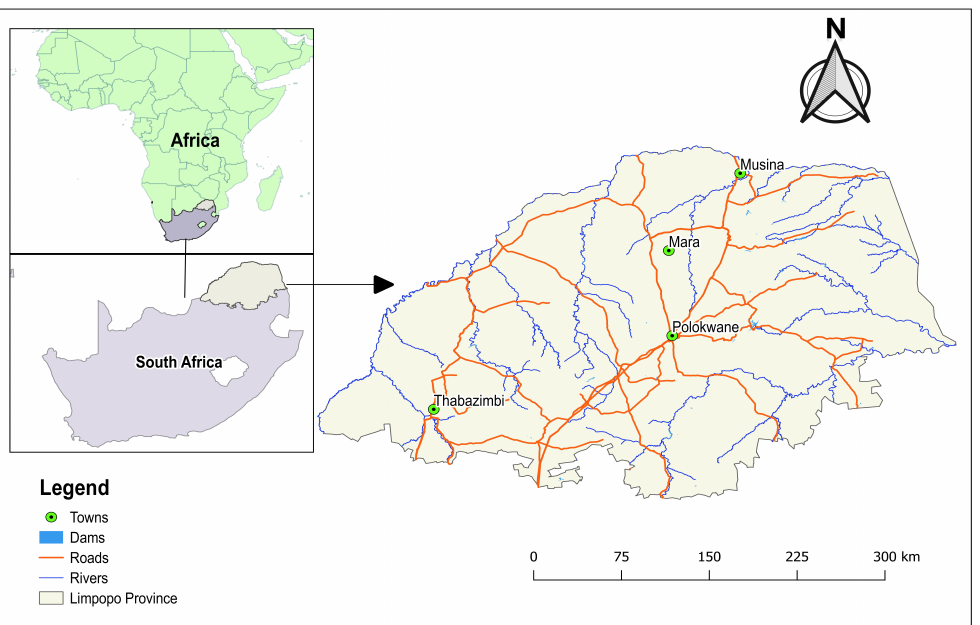
Figure 1. Map of Africa, South Africa and Limpopo Province with the main towns. Source: Au- thors’